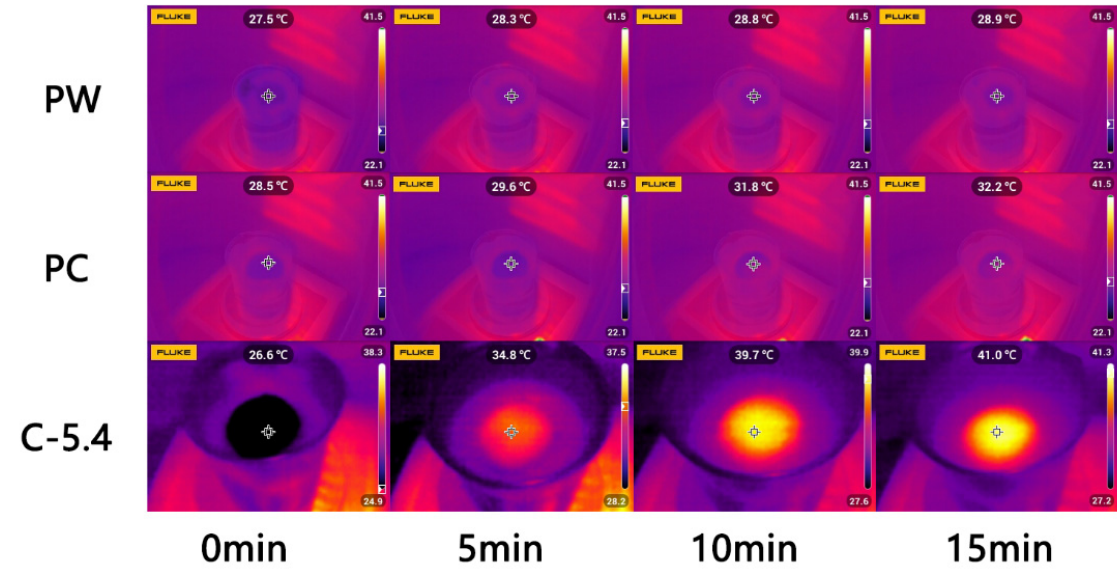
Figure 3. Infrared images of the PC, PW, and C-5.4 under 1 sun.